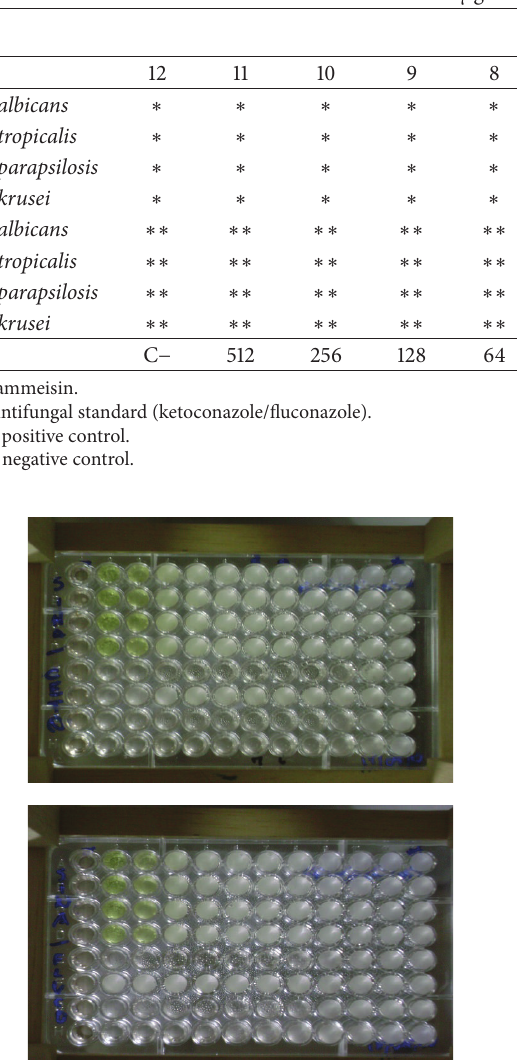
Figure 2: Antifungal experiment: concentrations 512-1 are given in units of 𝜇 g/mL. Photo above corresponds to experiment with ketoconazole as positive control and photo below shows experiment carried out with fluconazole as positive